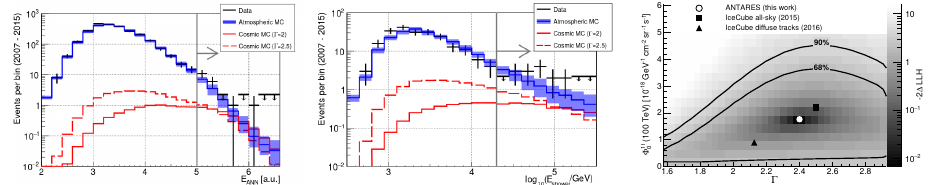
Figure 2. Distribution of the energy estimator for track-like (left panel) and shower-like (middle panel) events, after the event selection chain. The solid (dashed) red histogram shows the cosmic neutrino expectation for a cosmic flux proportional to E − 2 (E − 2 . 5 ) with normalization Φ 1 f (1.5 10 − 18 )GeV − 1 cm − 2 s − 1 sr − 1 . The blue line represents the sum of all atmospheric events. The gray × line represents the energy-related cut. Data after unblinding are shown as black crosses. Right: 2D log-likelihood scan of the di ff use cosmic flux normalization and spectral index obtained in the latest Antares search for a di ff use